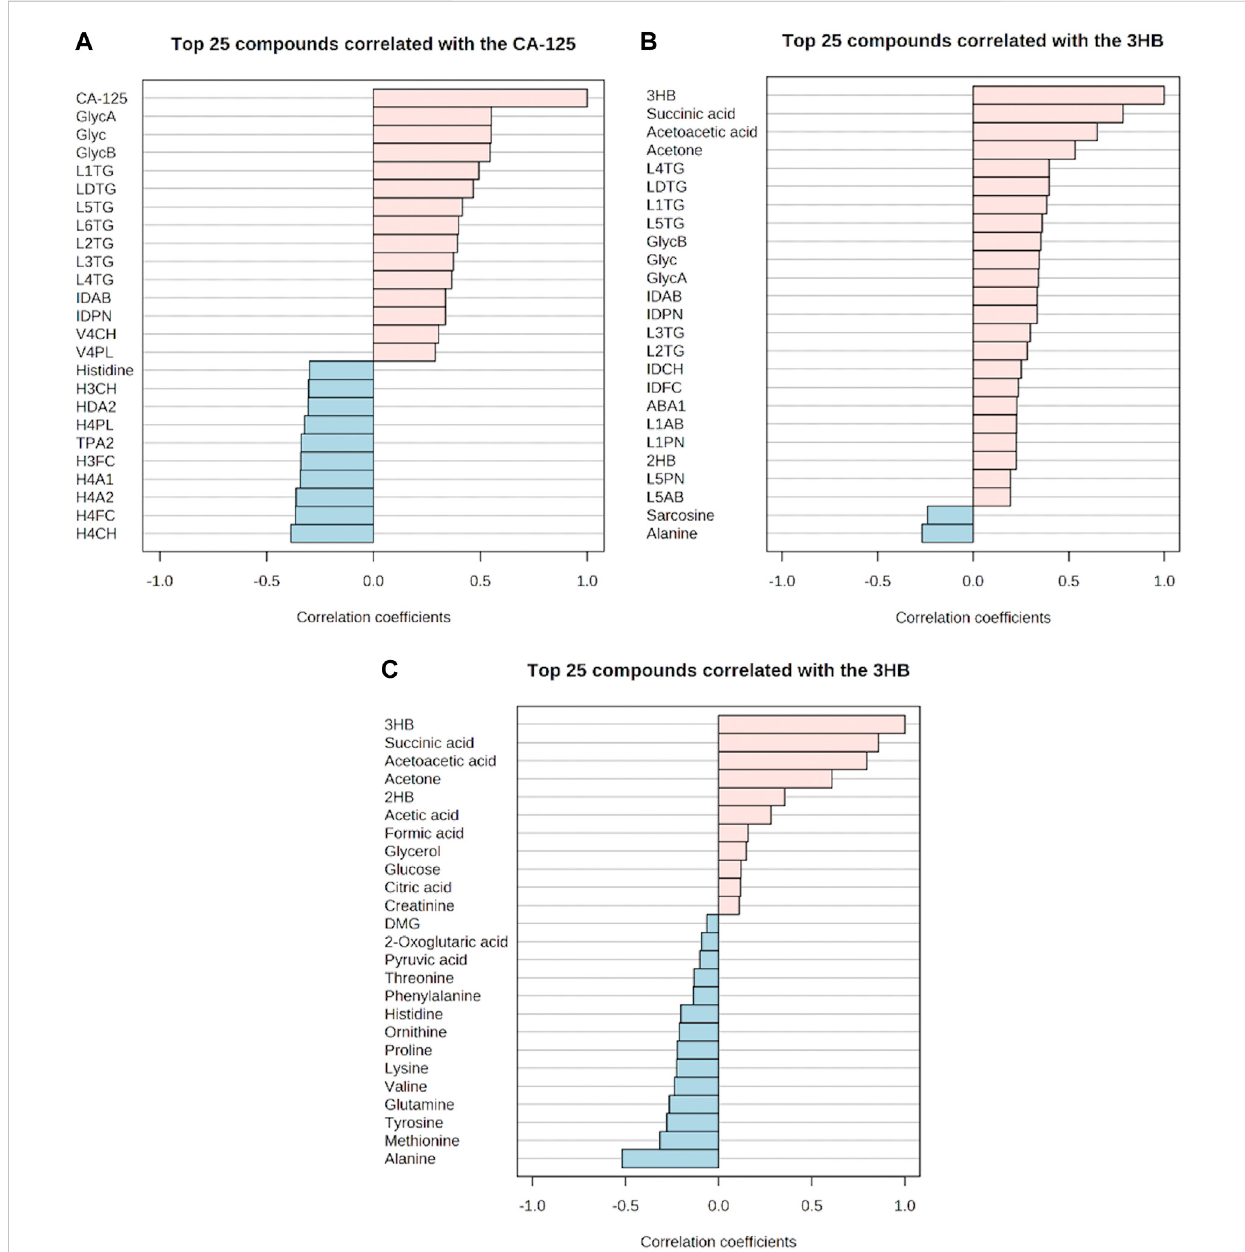
FIGURE 7 Correlation of the glycoprotein in fl ammation markers with metabolites, lipoproteins, and cancer antigen-125 markers. (A – C) Respective positive and negative correlations. (A) Positiveandnegativecorrelationsofcancerantigen-125withmetabolite,lipoproteins,andin fl ammationmarkers. (B) Positiveandnegativecorrelationsof 3-hydroxybutyricacidwithmetabolites,lipoproteins,andin fl ammationmarkers. (C)